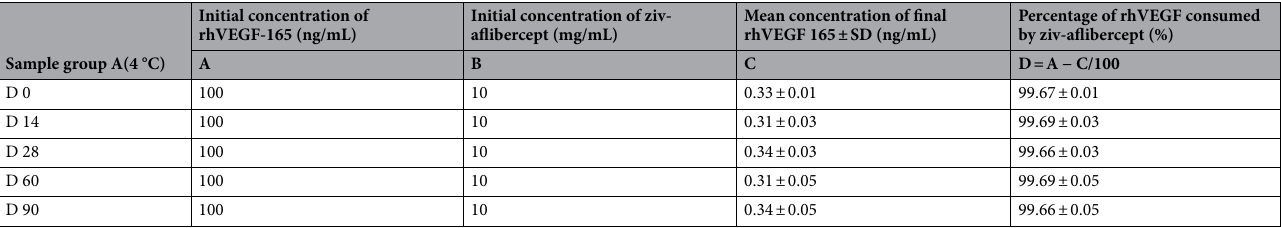
Table 3. Mean concentrations of rhVEGF-165 and efficacy of ziv-aflibercept in group A.